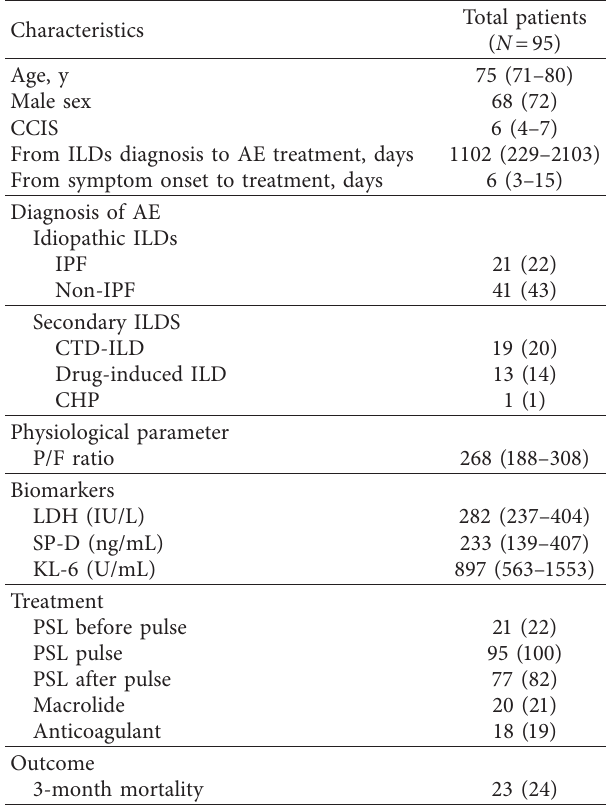
Table 1: Patients’